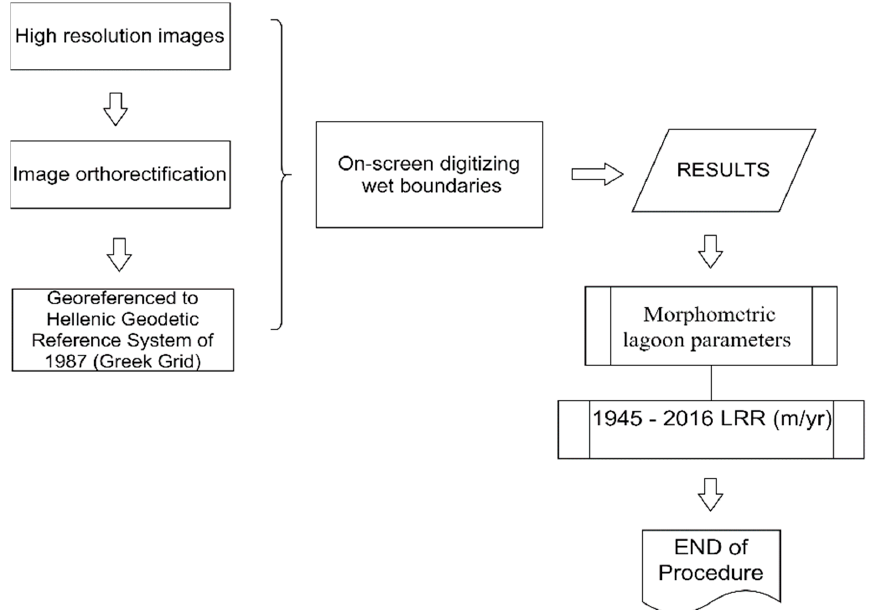
Figure 2. General workflow of the proposed methodology.